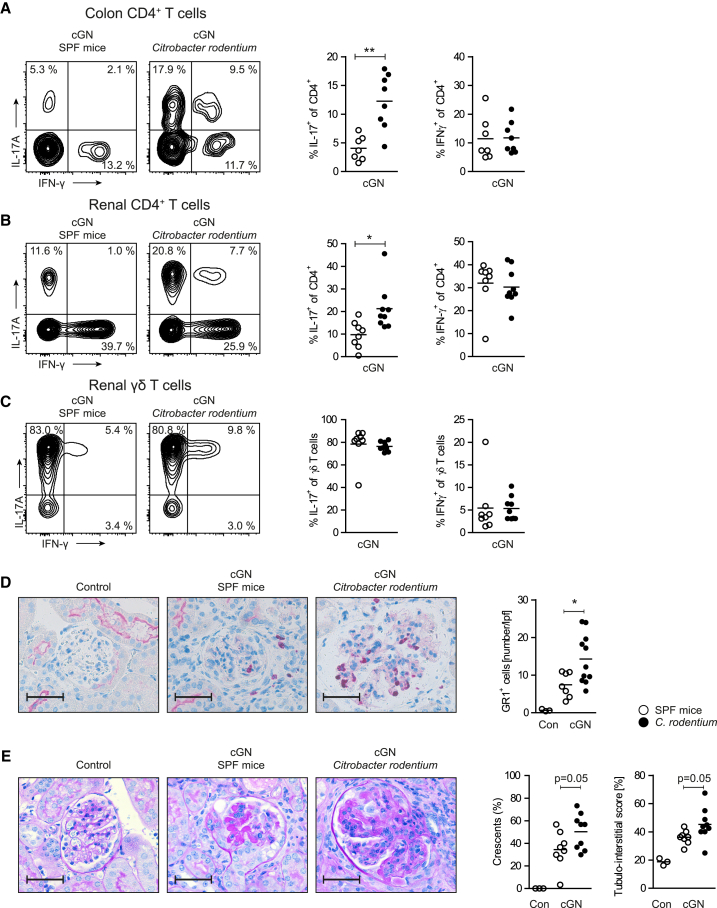
Expansion of Intestinal Th17 Cells by Citrobacter Rodentium Infection Aggravates Renal Th17 Immune Responses in cGN(A) Flow cytometry of large intestine lamina propria CD4+ T cells after infection with Citrobacter rodentium and induction of cGN.(B and C) (B) Renal CD4+ T cells and (C) renal γδ T cells were analyzed for intracellular cytokine expression.(D) GR-1 staining and quantification of neutrophil infiltration in the renal cortex from mice with cGN.(E) Kidney damage was assessed by evaluation for glomerular crescents and tubulointerstitial damage in PAS-stained renal cortex sections. Scale bar, 25 μm.Data are representative of three independent experiments. Symbols represent individual data points, with the mean as a horizontal line.∗p < 0.05, ∗∗p < 0.01.